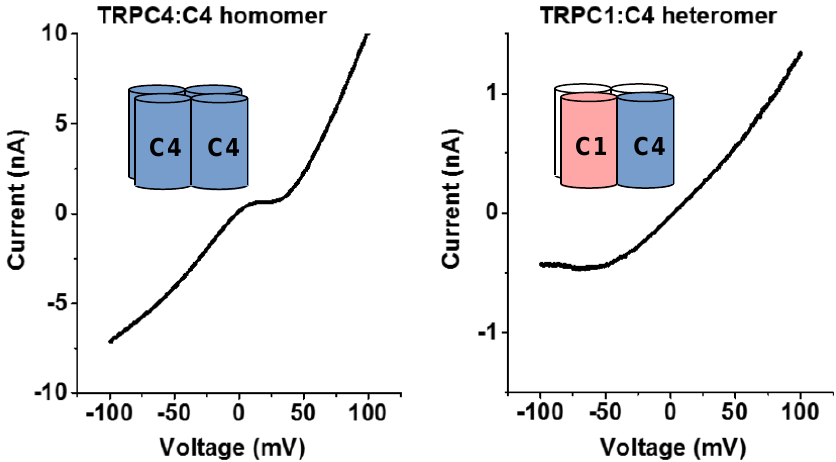
Figure 2. Example I–V plots of homomeric ( left ) and heteromeric/concatemeric ( right ) TRPC1/4/5 channels. Recordings from overexpressed TRPC4:C4 and TRPC1:C4 channels are shown. For examples of native I–V plots, see references [14,16].